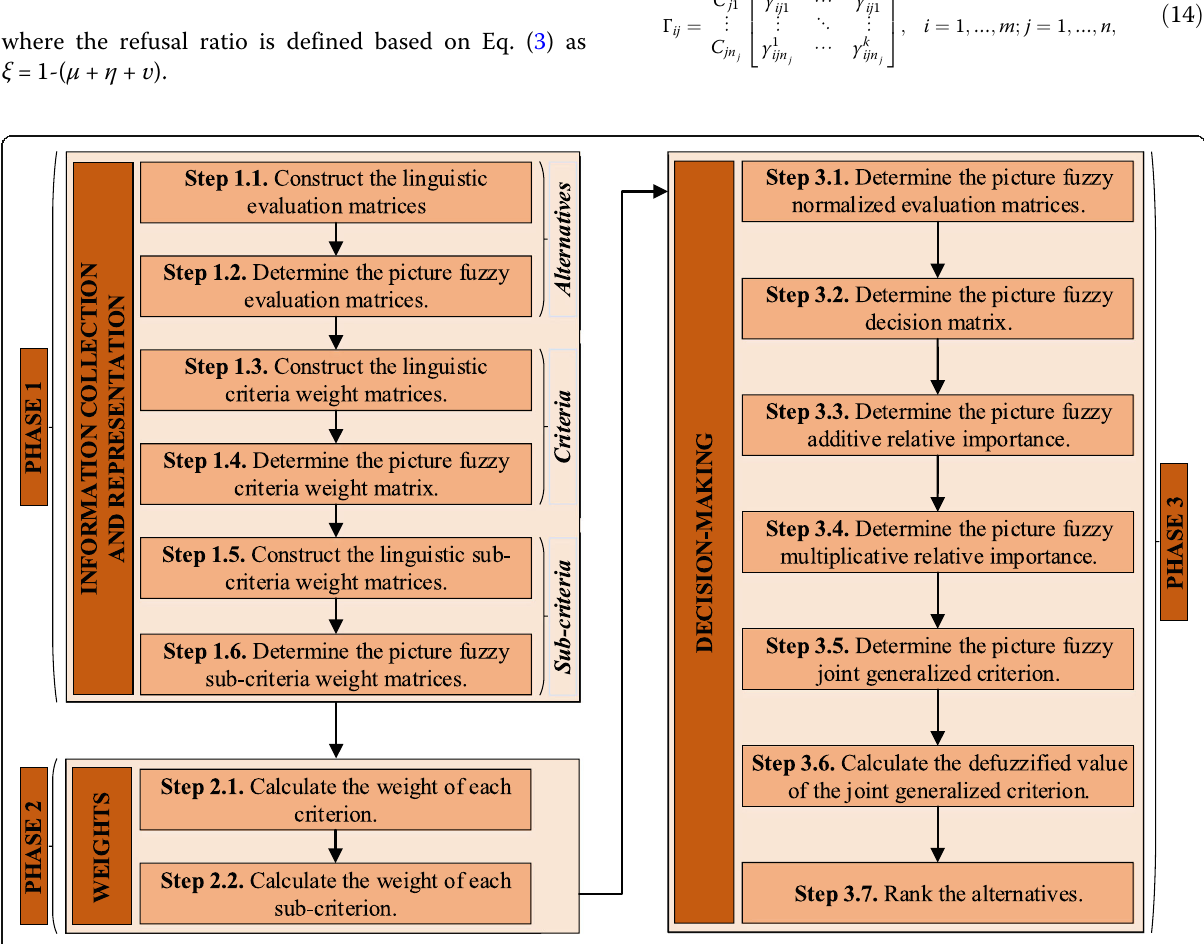
Fig. 1 The flowchart of the developed picture fuzzy WASPAS